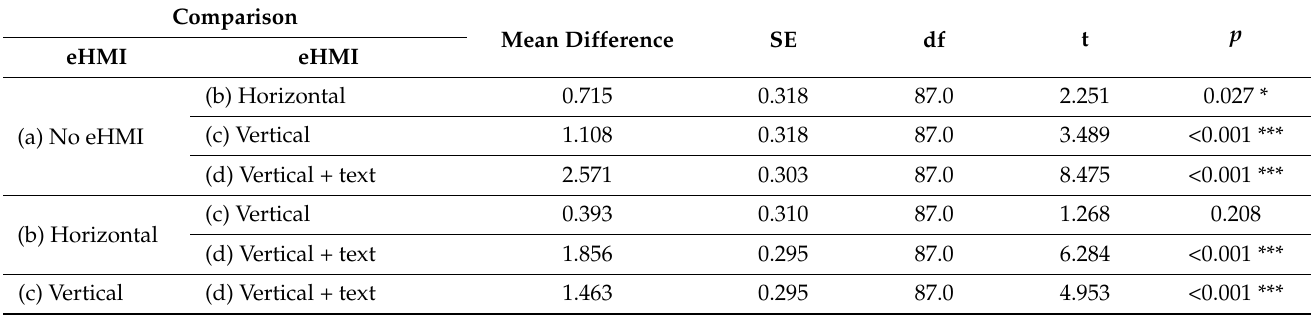
Table 3. Post hoc comparison of the time until over 4 reached of the willingness to stop scale.